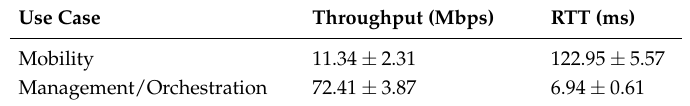
Table 2. Considered throughput and round trip time (RTT) values (95% confidence